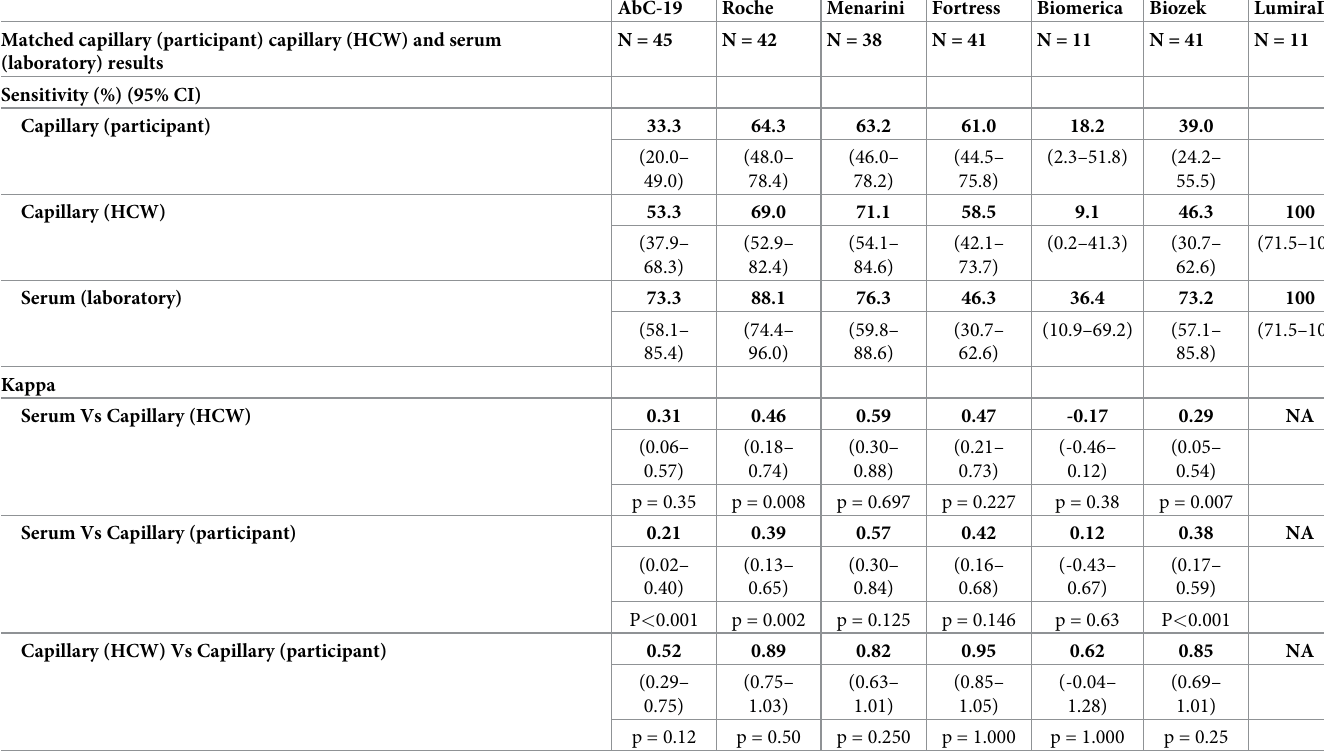
Table 5. Comparison of paired serum and capillary results on selected POC